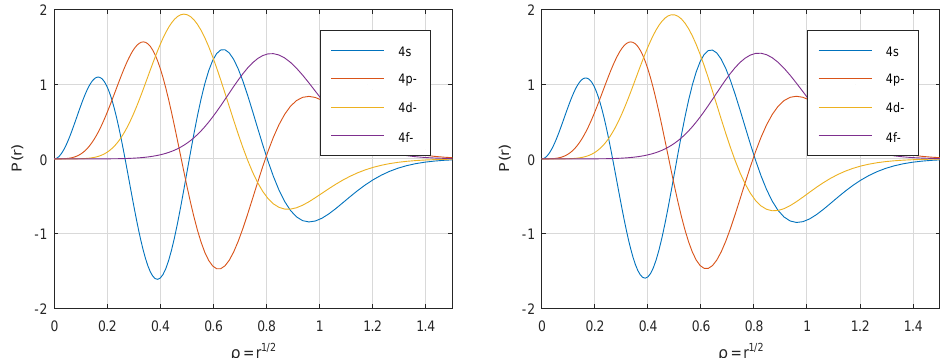
Figure 12. Plot of orbitals from an rmcdhf calculation using the full interaction matrix and an rmcdhf calculation with only part of the